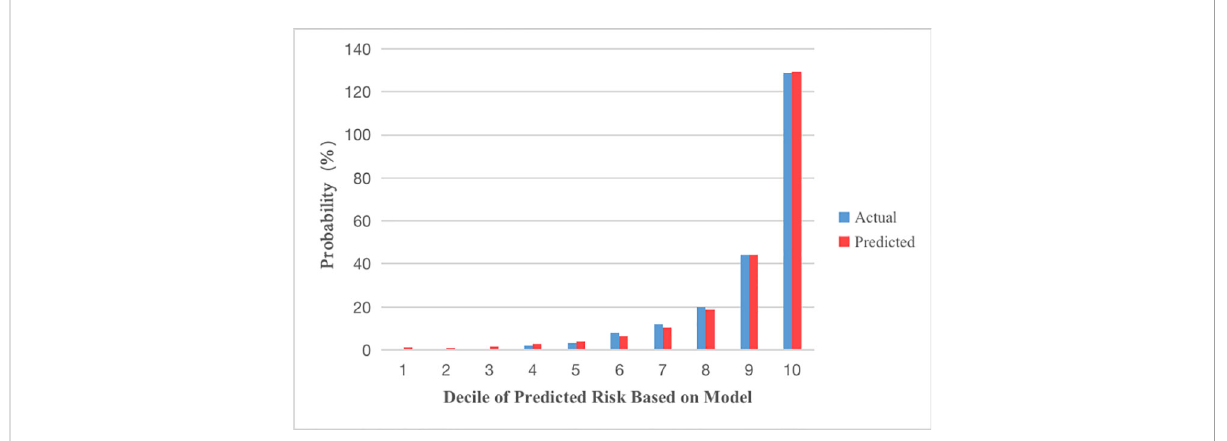
FIGURE 4 Calibration plots show the relationship between the predicted probabilities base on the prediction model and actual values of the development cohorts. The x-axis represents deciles of predicted risk, and the y-axis reveals predicted and actual prevalence of DK. The H-L chi-square which measure the calibration was 4.255 (P =